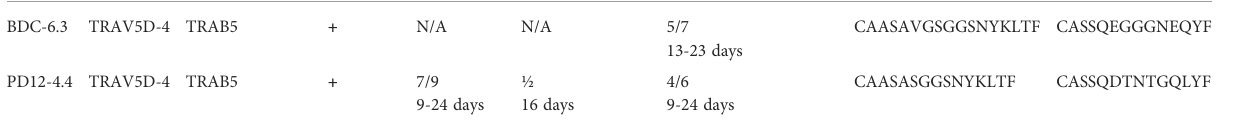
TABLE 1 Features of insulin-responsive T cell clones.